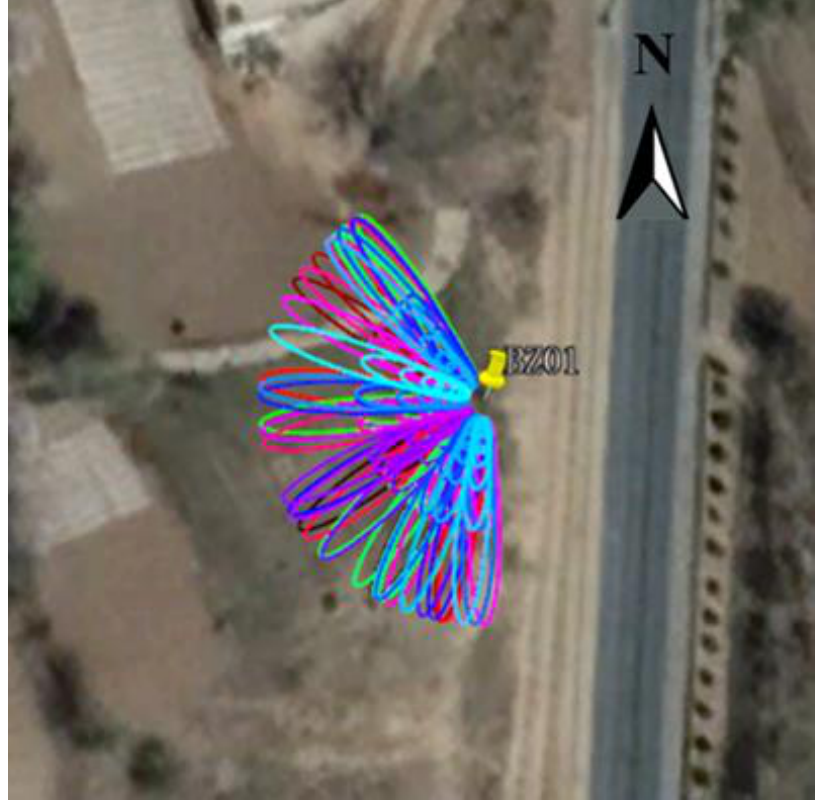
◦ –360 ◦ azimuth at BZ01